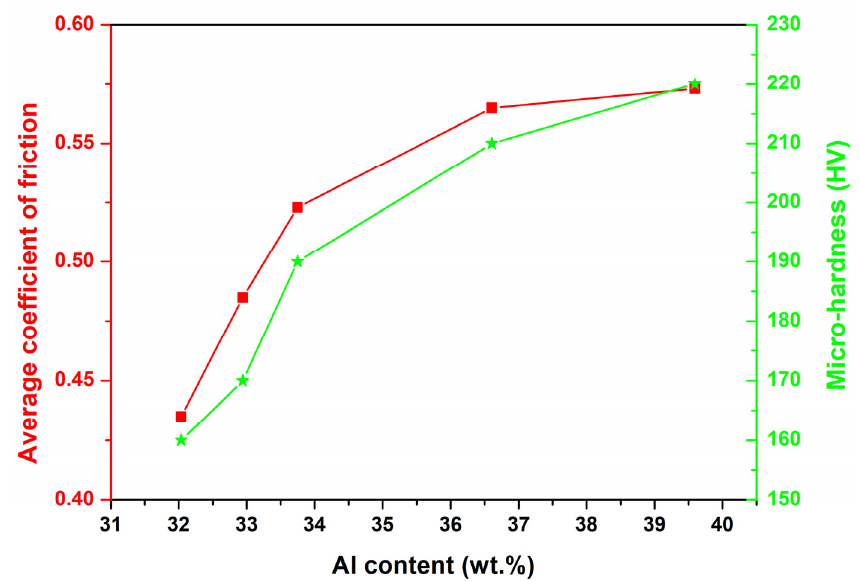
Figure 12. Relationship between Al content and the average coefficient of friction / microhardness.